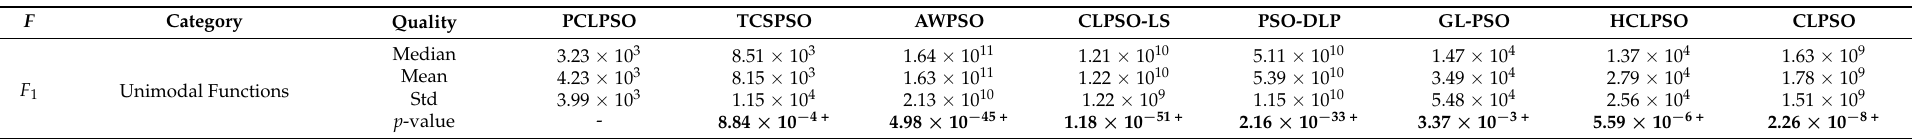
Table 5. Global fitness comparisons between PCLPSO and the seven selected PSO methods on the CEC 2017 benchmark set with the dimensionality set as